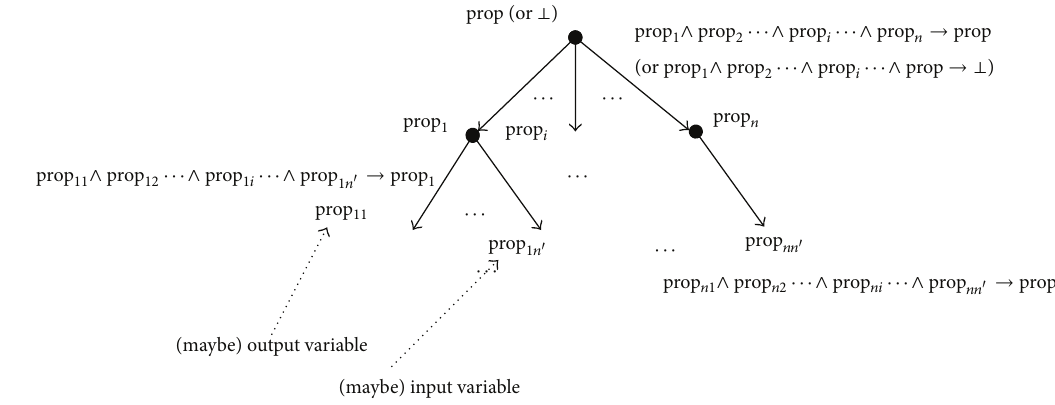
Figure 3: Reasoning tree in state space